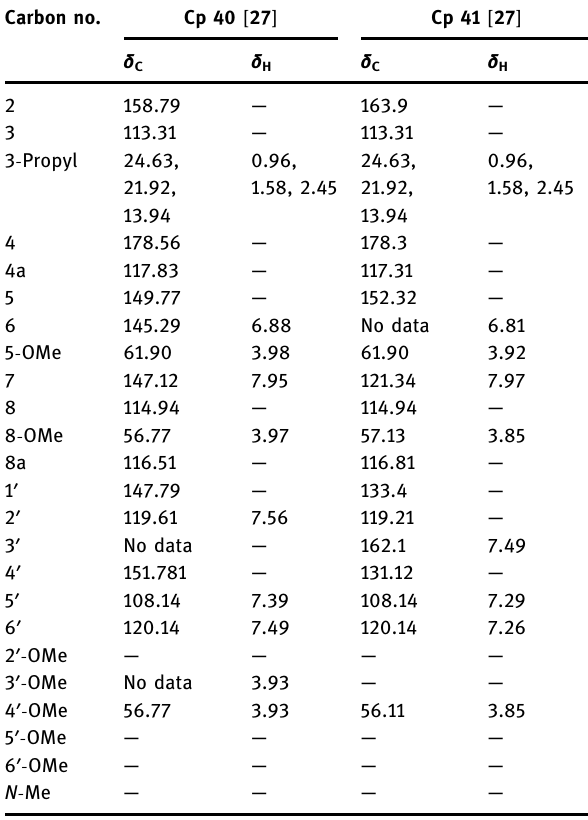
Table 13: 13 C and 1 H NMR chemical shift data ( δ , ppm ) of quinolinone and quinolone alkaloids isolated from genus Casimiroa Carbon